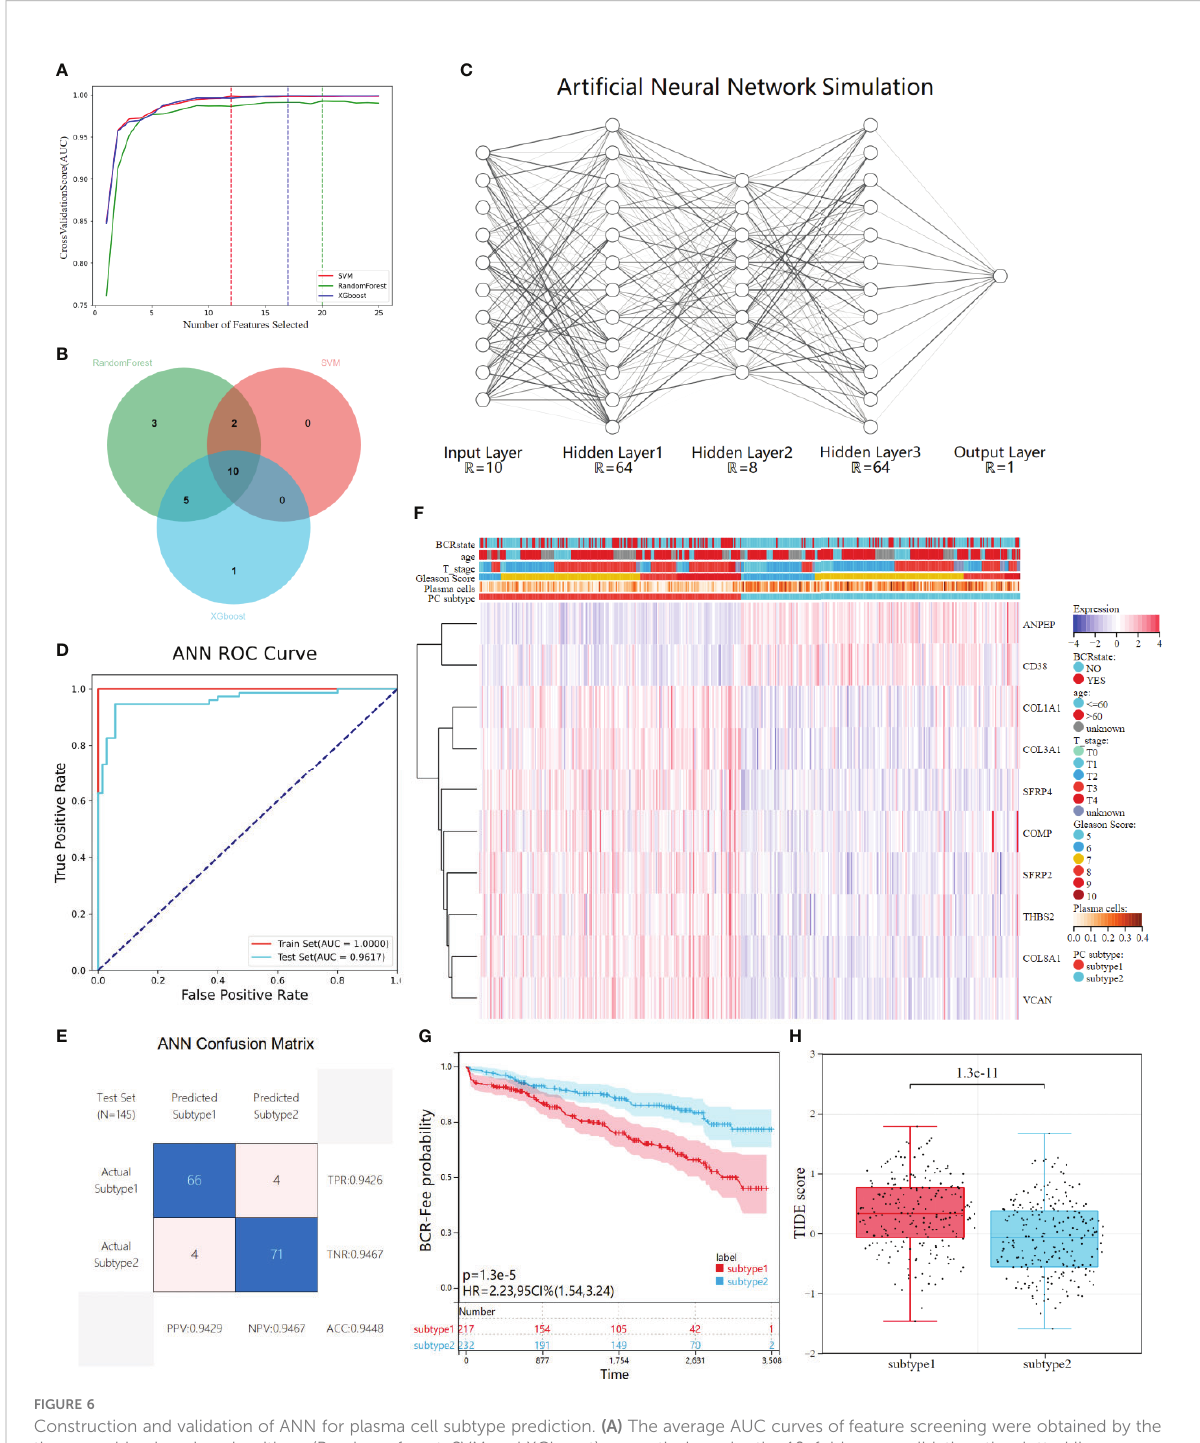
FIGURE 6 Construction and validation of ANN for plasma cell subtype prediction. (A) The average AUC curves of feature screening were obtained by the three machine learning algorithms (Randoms forest, SVM and XGboost) respectively under the 10-fold cross-validation, the dotted line represents the best number of features. (B) Venn diagrams shows 10 characteristic genes of plasma cell subtypes shared by the three machine learning models. (C) The ANN simulation diagram includes three hidden layers except the input&output layer, and the neurons in each layer are (64,8,64), respectively. Regions larger than 12 neurons are omitted due to plotting limitations. (D) The ROC curves of the ANN in distinguishing two subtypes in the train set and test set. (E) Confusion matrix and evaluation parameters in test set. (F) The GEO independent validatiob queue was predicted using ANN, and the expression of 10 characteristics genes was visualized through heat maps. (G) Kaplan-Meier survival analysis showed differences in biochemical recurrence-free probability among plasma cell subtypes in the GEO independently validated cohort. (H) There were differences in TIDE scores between the tow plasma cell subtypes in the GEO